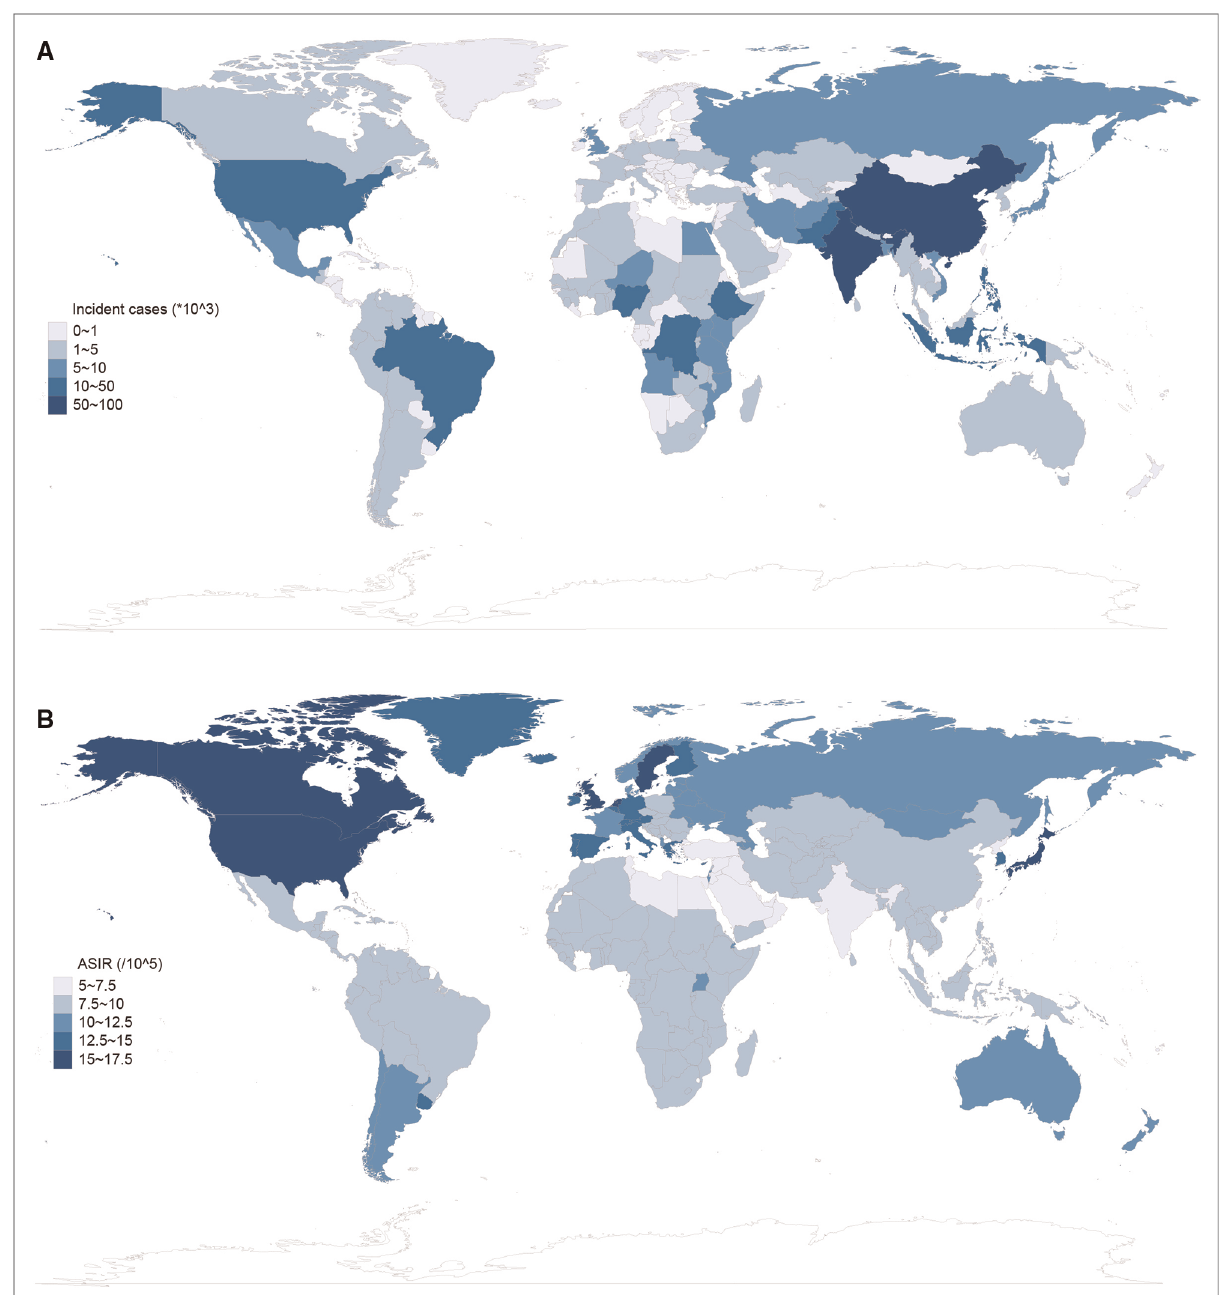
FIGURE 2 Global incidence of autism spectrum disorder in 2019. ( A ) Incident cases of autism spectrum disorders by location for both sexes in 2019. ( B ) Age-standardized incidence rate (ASIR) of autism spectrum disorders by location for both sexes in